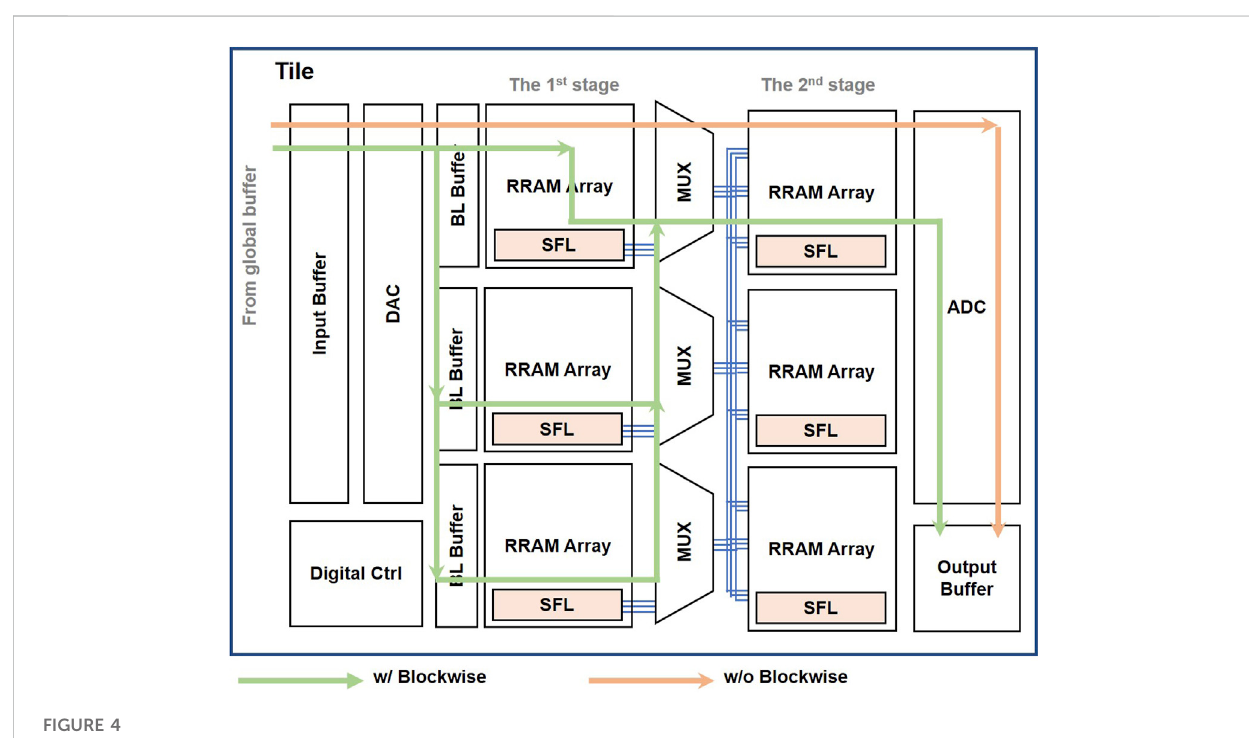
FIGURE 4 Tile level of LINKAGE